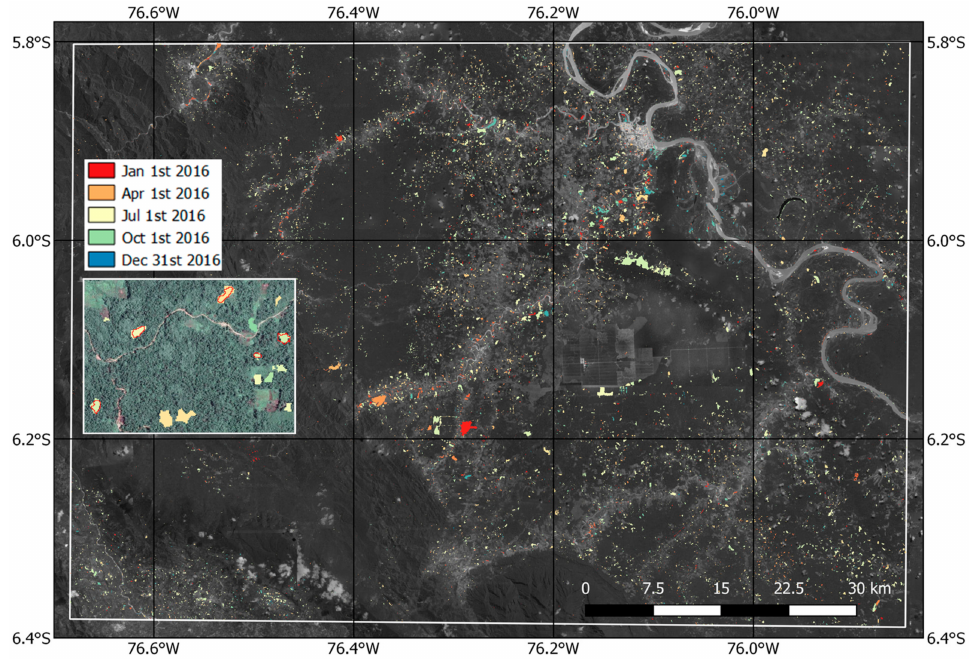
Figure 12. Deforestation map for year 2016 over the study site. In the 1.5 km × 2.0 km subset (left), the automatically selected deforestation reference samples are shown as red polygons. (Background optical image from Google Earth, in